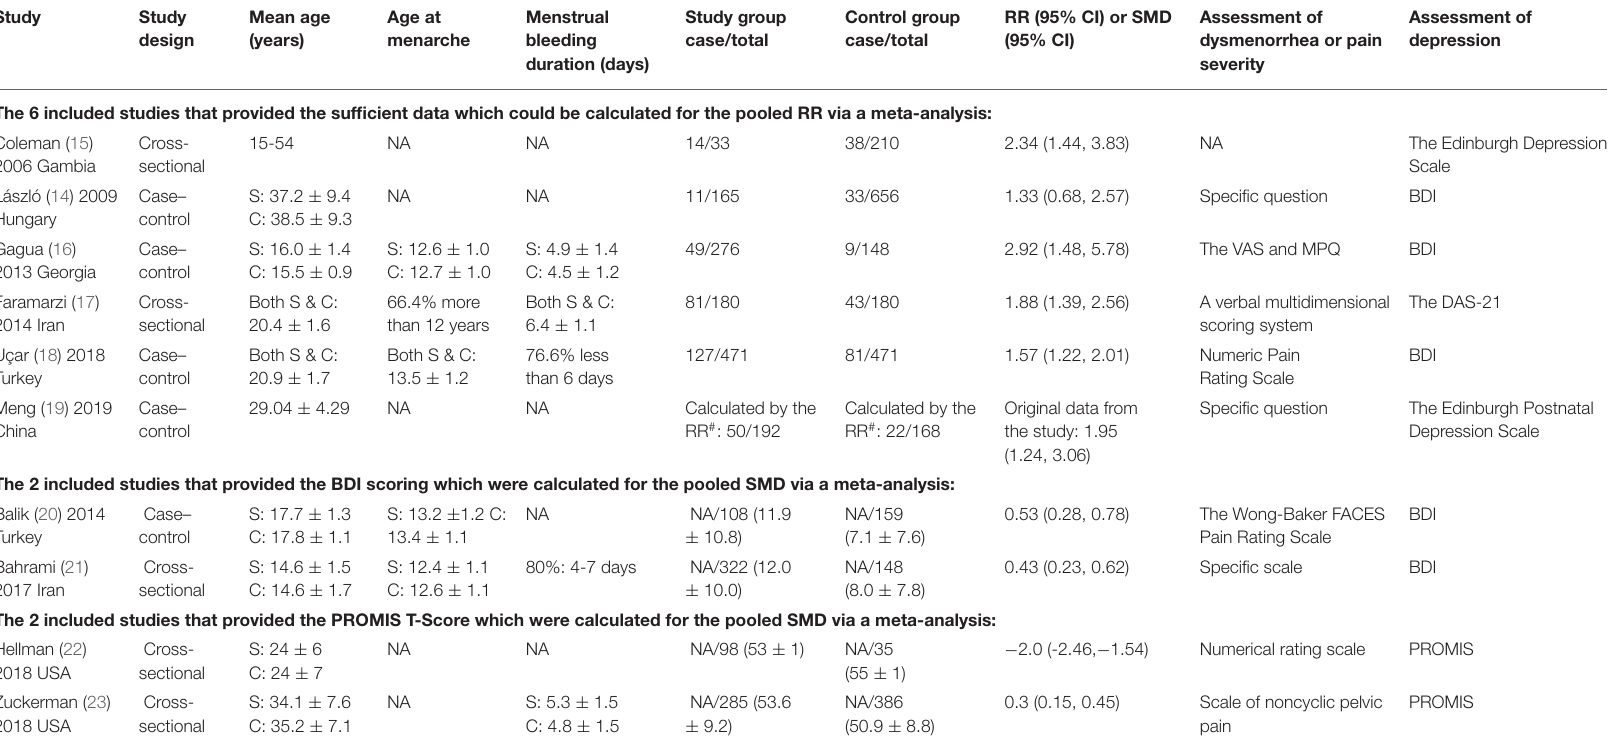
TABLE 1 | Characteristics of the included